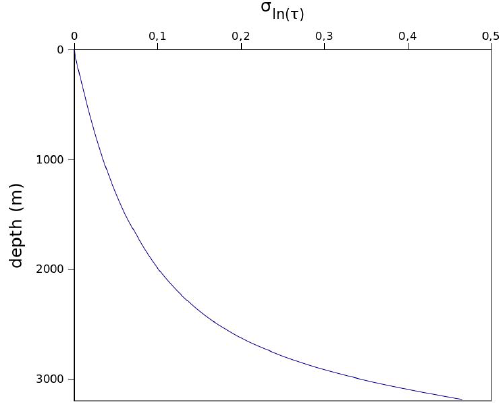
Fig. 1. Function f (z) in EDC as described in Eq. (9).